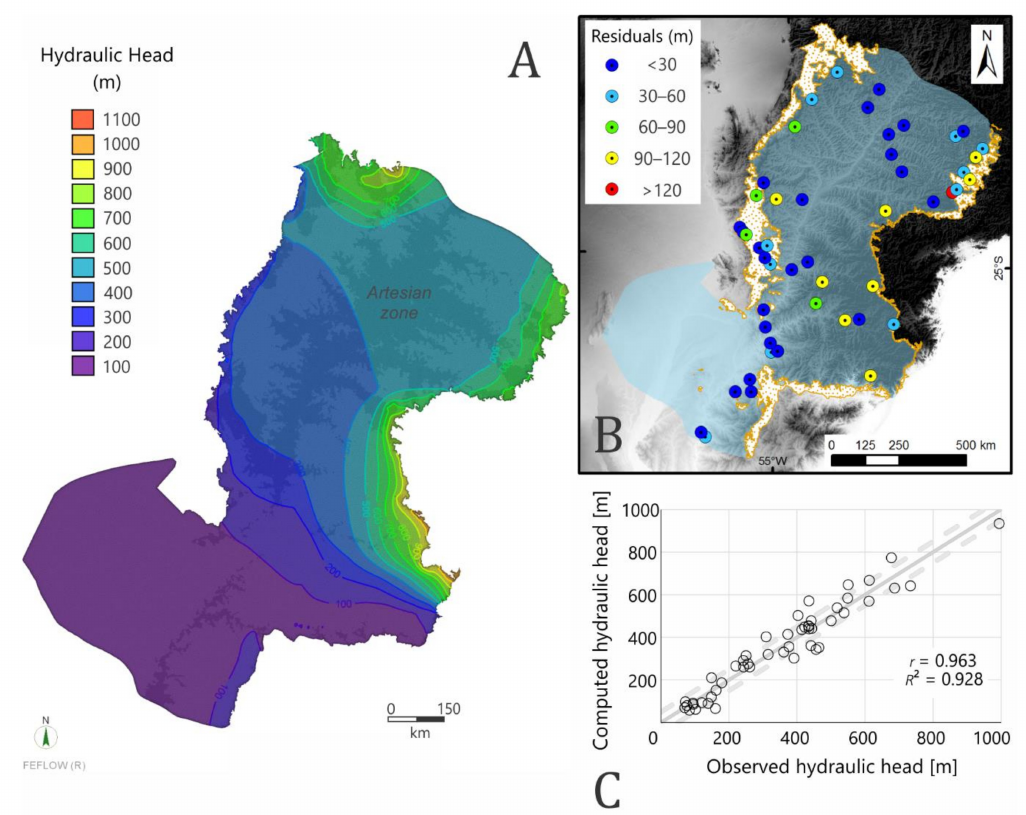
Figure 4. ( A ) Calculated hydraulic head distribution, ( B ) map of residuals, and ( C ) scatter plot showing simulated and observed piezometric levels (in meters above mean sea level).